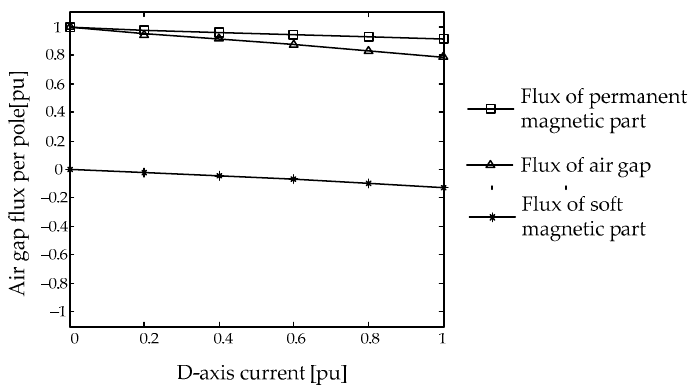
Figure 8. The curve of air gap flux under different d -axis current. The area ratio is 0.3.